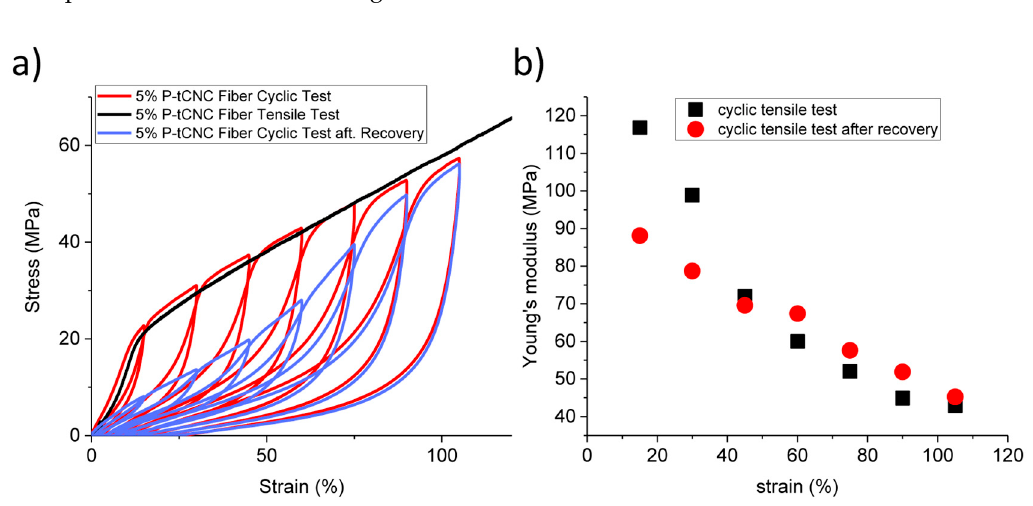
Figure 5. ( a ) Cyclic tensile test experiments performed on 5 wt% P-tCNC nanocomposite fibers, raising the strain to 5%, 15%, 30%, 45%, 60%, 75%, 90%, 105%, followed by unloading the sample (red). After a full series of cycles, the fibers were annealed for 3 days at 50 °C and the measurement was repeated (blue). A simple non-cyclic tensile test is shown for comparison (black). ( b ) Evolution of Young’s modulus during the cyclic tensile test before and after recovery, showing that the initial stiffness can only be partially recovered.